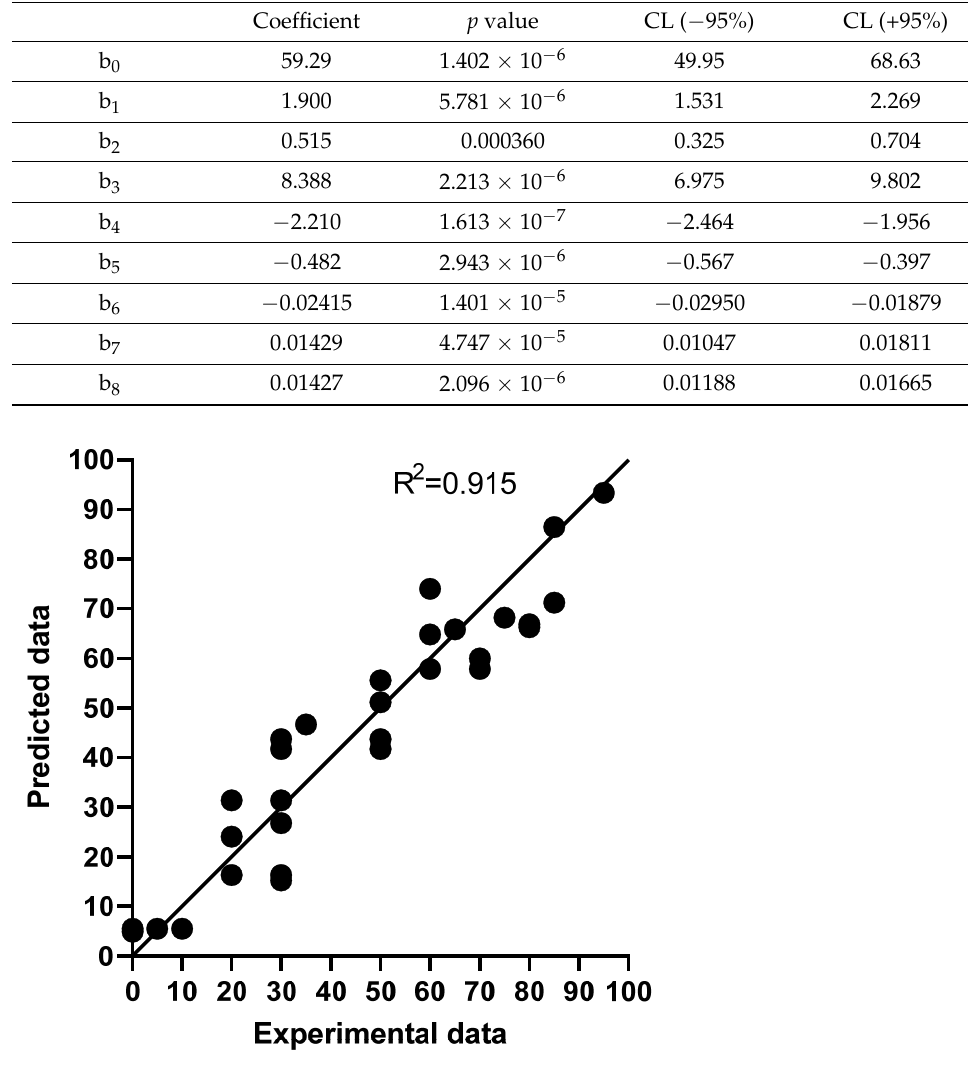
Figure 2. Relationship between the experimental survivability of Anisakis after the application in saline solution of PEF treatments of different rates of field strength (1–3 kV/cm), specific energy (9–50 kJ/kg), and pulse width (3–100 µs) compared with the survivability estimated with the equation shown in Table 2.